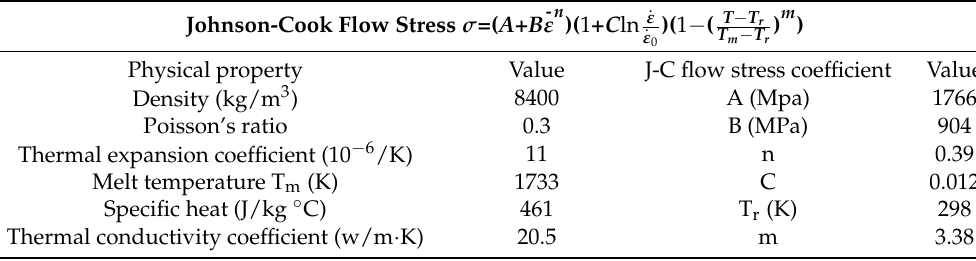
Table 3. Material properties and Johnson–Cook flow stress coefficient of SKD11 tool steel